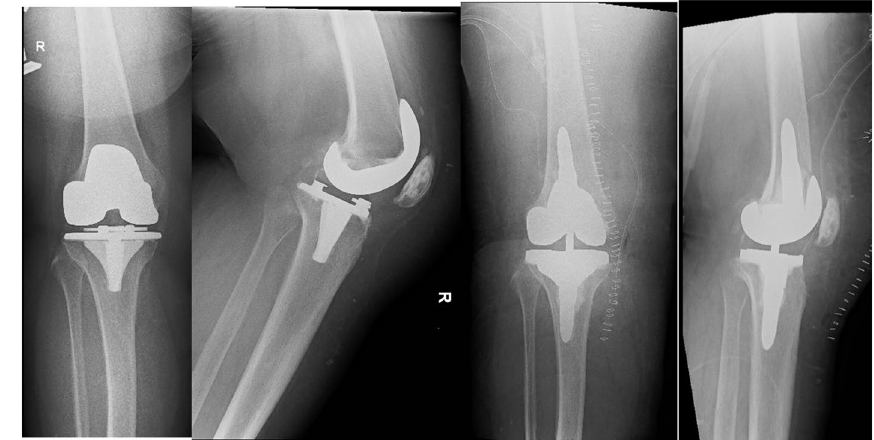
Fig. 17 Pre‑ and postoperative radiographs of patient for preoperative planning in Fig. 7